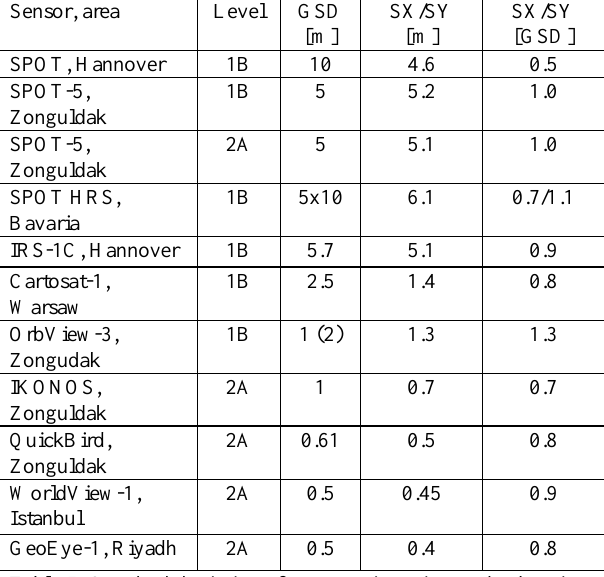
Table 5. Standard deviation of sensor orientation at check